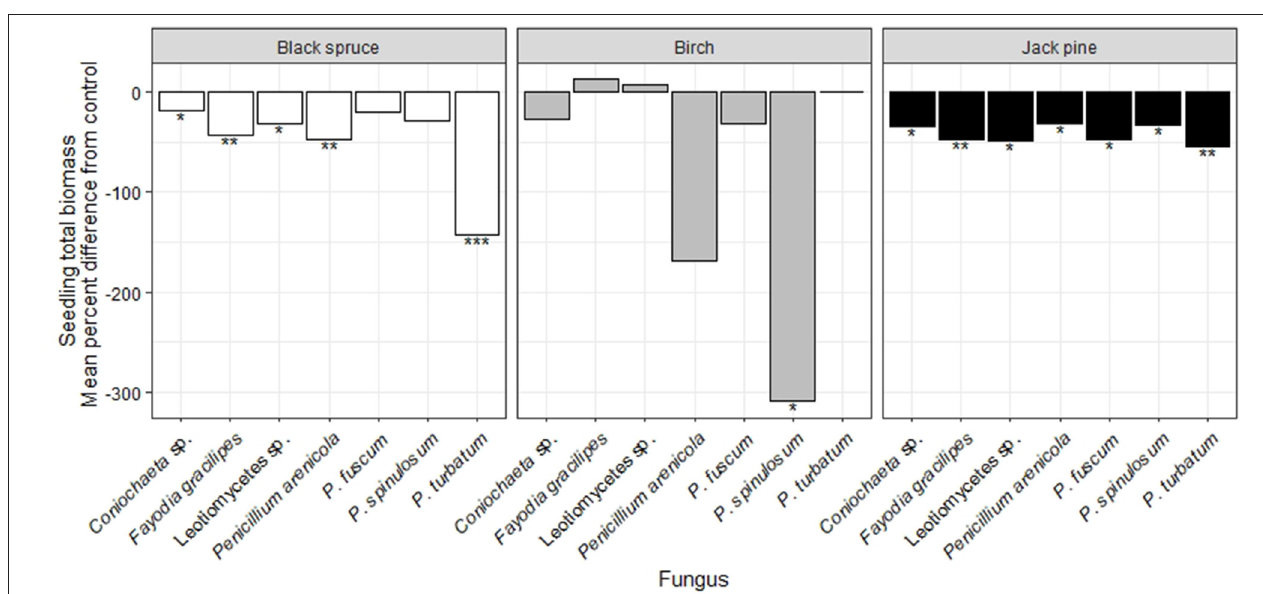
FIGURE 4 | Effects of seven heat-resistant fungi on seedling total biomass of black spruce (white bars), birch (gray bars), and jack pine (black bars) in growth chamber experiments over 10 wks. Results are presented as the mean percent difference for each fungal treatment from the uninoculated control treatment, based on 999 bootstraps. Values above zero indicate greater biomass when the fungus was inoculated, relative to the control. Asterisks indicate statistically significant differences relative to the control treatment from linear models ( * P < 0.05; ** P < 0.01; *** P < 0.001; Table S6 ).